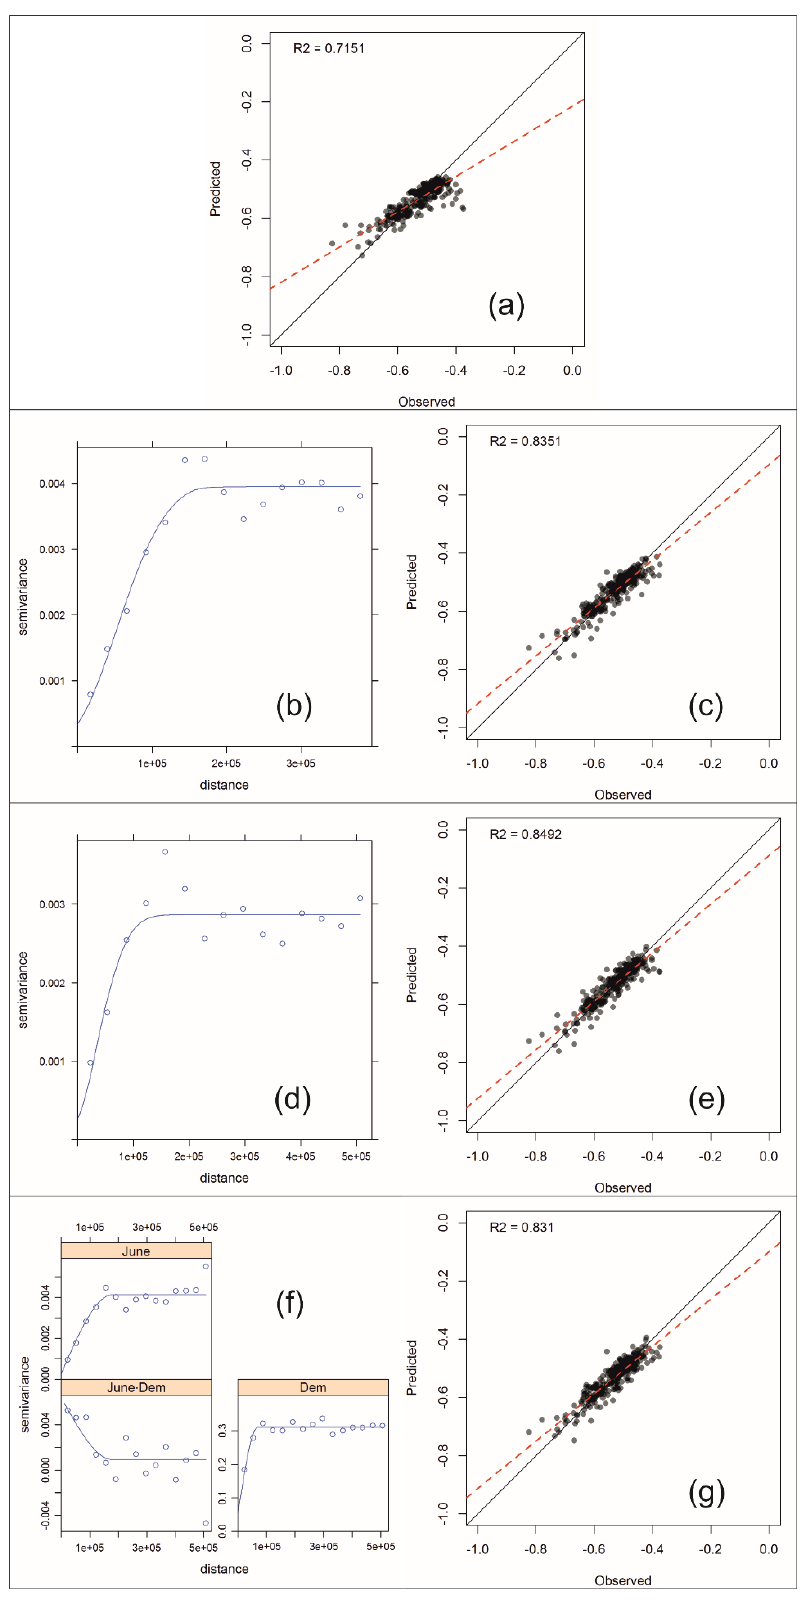
Figure 2. Scatterplots between observed and estimated monthly precipitation in June for ( a ) inverse distance weighting (IDW), ( c ) ordinary kriging (OK), ( e ) kriging with an external drift (KED), and ( g ) ordinary cokriging (COK). Related semi-variograms in June for ( b ) OK, ( d ) KED, and ( f ) cross- variograms in June for COK. Distance is expressed in meters. DEM stands for Digital Elevation Model.